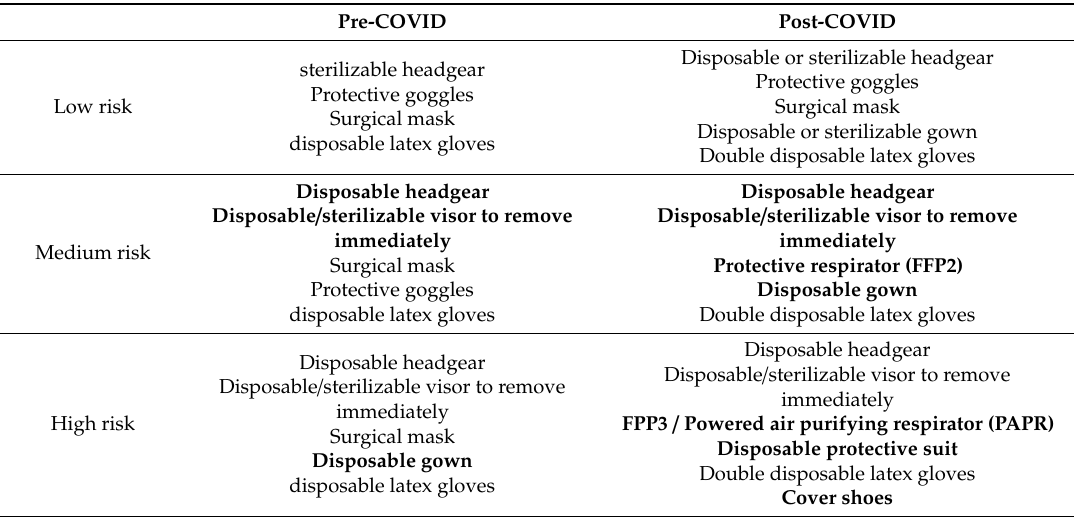
Table 8. Proposal of modulation of personal protective equipment (PPE) according to level of risk or common dental procedures both in pre-COVID and post-COVID era (bold style means the introduction of the new PPE due the transition from a risk category to a higher